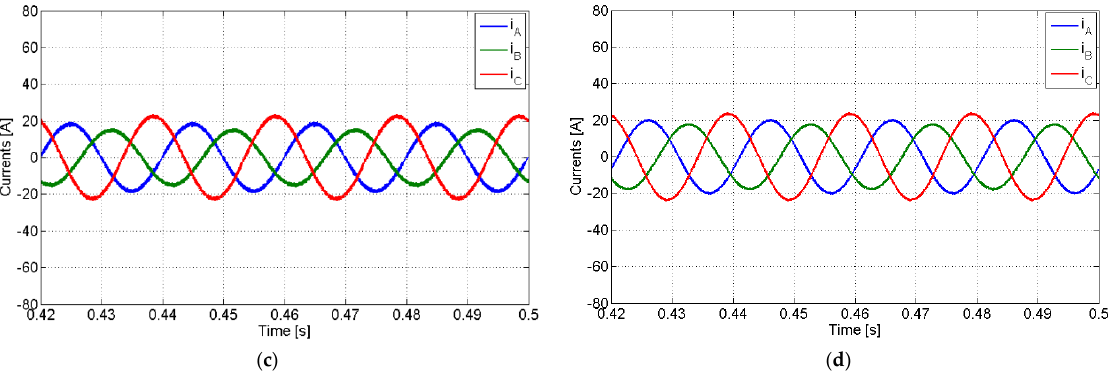
Figure 10. Simulation results with the PV generator in subcompensation mode with a linear load and compensation of the active power imbalance: ( a ) voltage applied to the primary phase of the transformer (phase B); ( b ) current in the line between the fourth leg of the inverters; ( c ) AC currents of the PV generator; ( d ) grid currents.